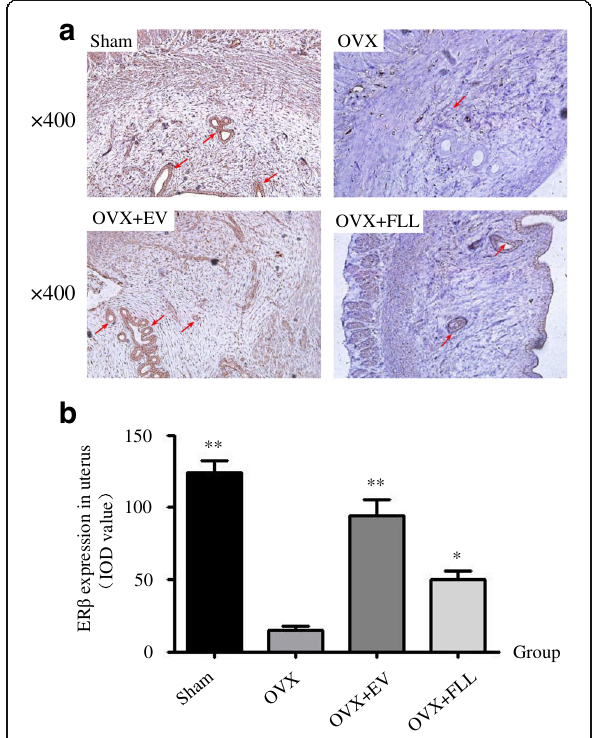
Fig. 5 The representative images ( a ) and images analysis results of immunohistochemical staining ( b ) showing the effect of FLL on ER β expression in the uteri of the rats. The arrows illustrated the expression and distribution of ER β . Data are presented as mean±SD. * P <0.05 or ** P <0.01 compared with the OVX control group Fig. 6 The representative images ( a ) and images analysis results of